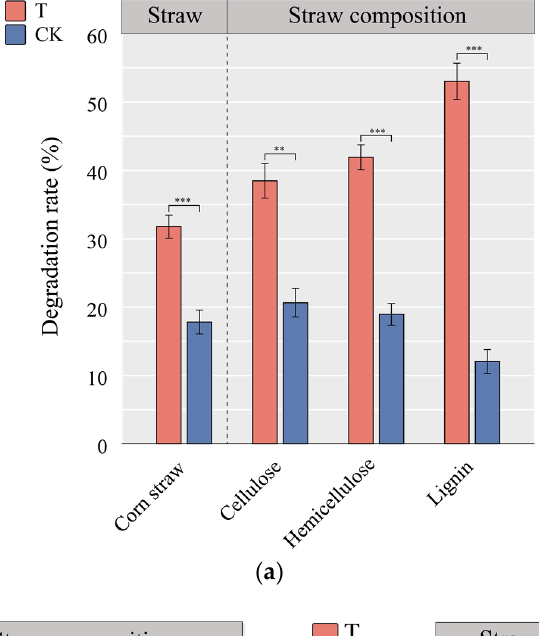
( b ) Figure 3. Lignocellulase activity of the tested bacterial agents. Cellulosic and hemicellulosic ( a ) and ligninolytic ( b ) enzyme activities of the tested bacterial agents. Different letters represent significant differences ( p < 0.05). The degradation effects of the bacterial agents on corn stover in the field tests in 2020 and 2021 are presented in Figure 4b,c. In 2021, the degradation rate of stover and its com- ponents by the bacterial agent was generally lower than that in 2020 due to the difference in soil temperature and moisture; however, the results of both experiments showed that the degradation rate of stover treated with the bacterial agent was significantly higher than those of the control group. In 2020 and 2021, the degradation rates of stover with the applied bacterial agent were 34.10% and 29.60%, which were 15.74% and 12.94% higher